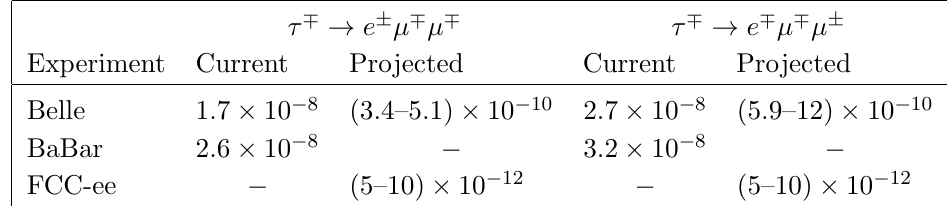
! e (cid:7) (cid:6) (cid:22) (cid:7) (cid:22) (cid:7) and (cid:28) (cid:7)